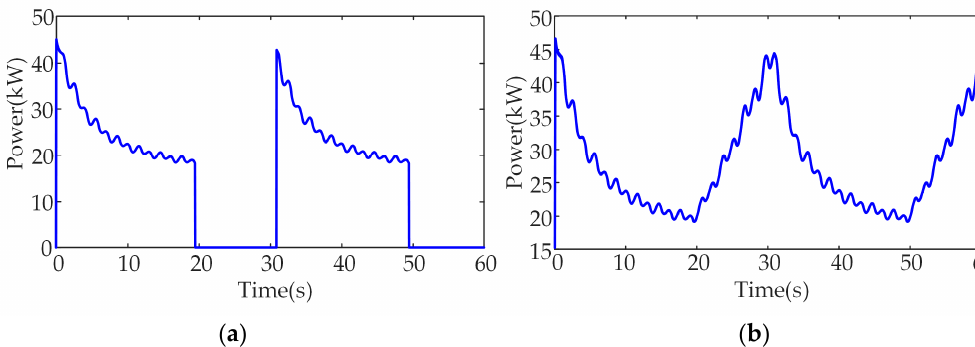
Figure 9. Power Curve. ( a ) Power of G1; ( b ) power of G2.